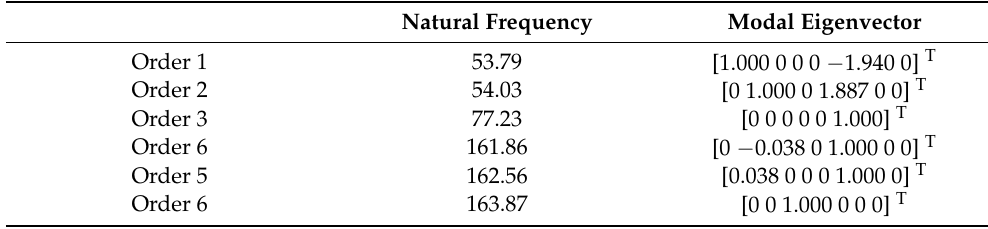
Table 3. Natural frequencies and corresponding modes of the